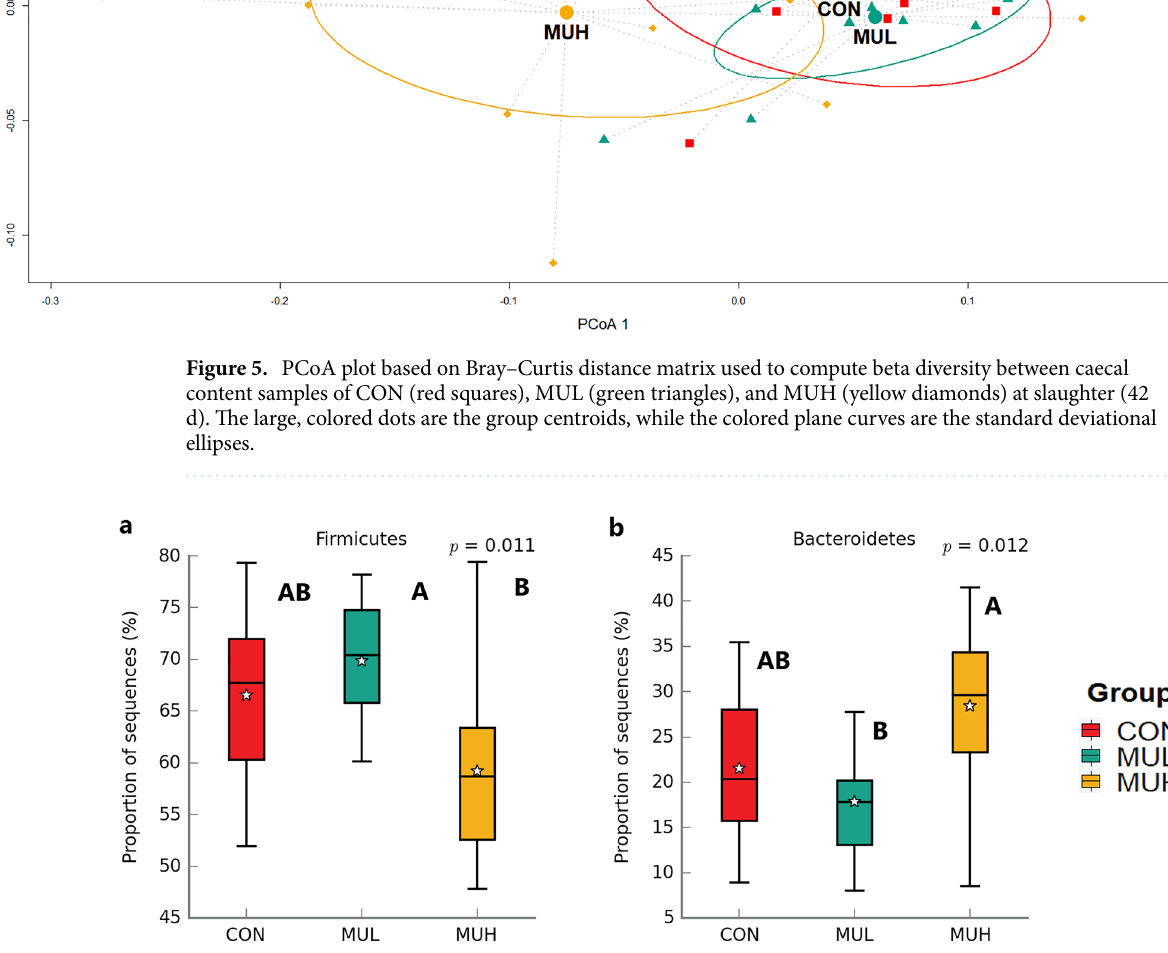
Figure 6. Relative abundance of caecal Firmicutes ( a ) and Bacteroidetes ( b ) of CON, MUL, and MUH at slaughter (42 d). Group means are drawn as white stars inside the boxes. Kruskal–Wallis H-test p -values are reported in the top-right corner. A, B: p -value <